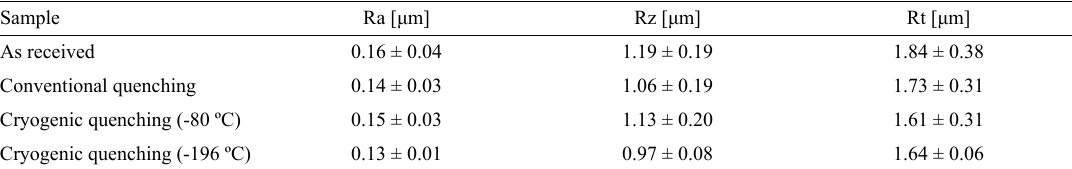
Table 6. Surface roughness values.